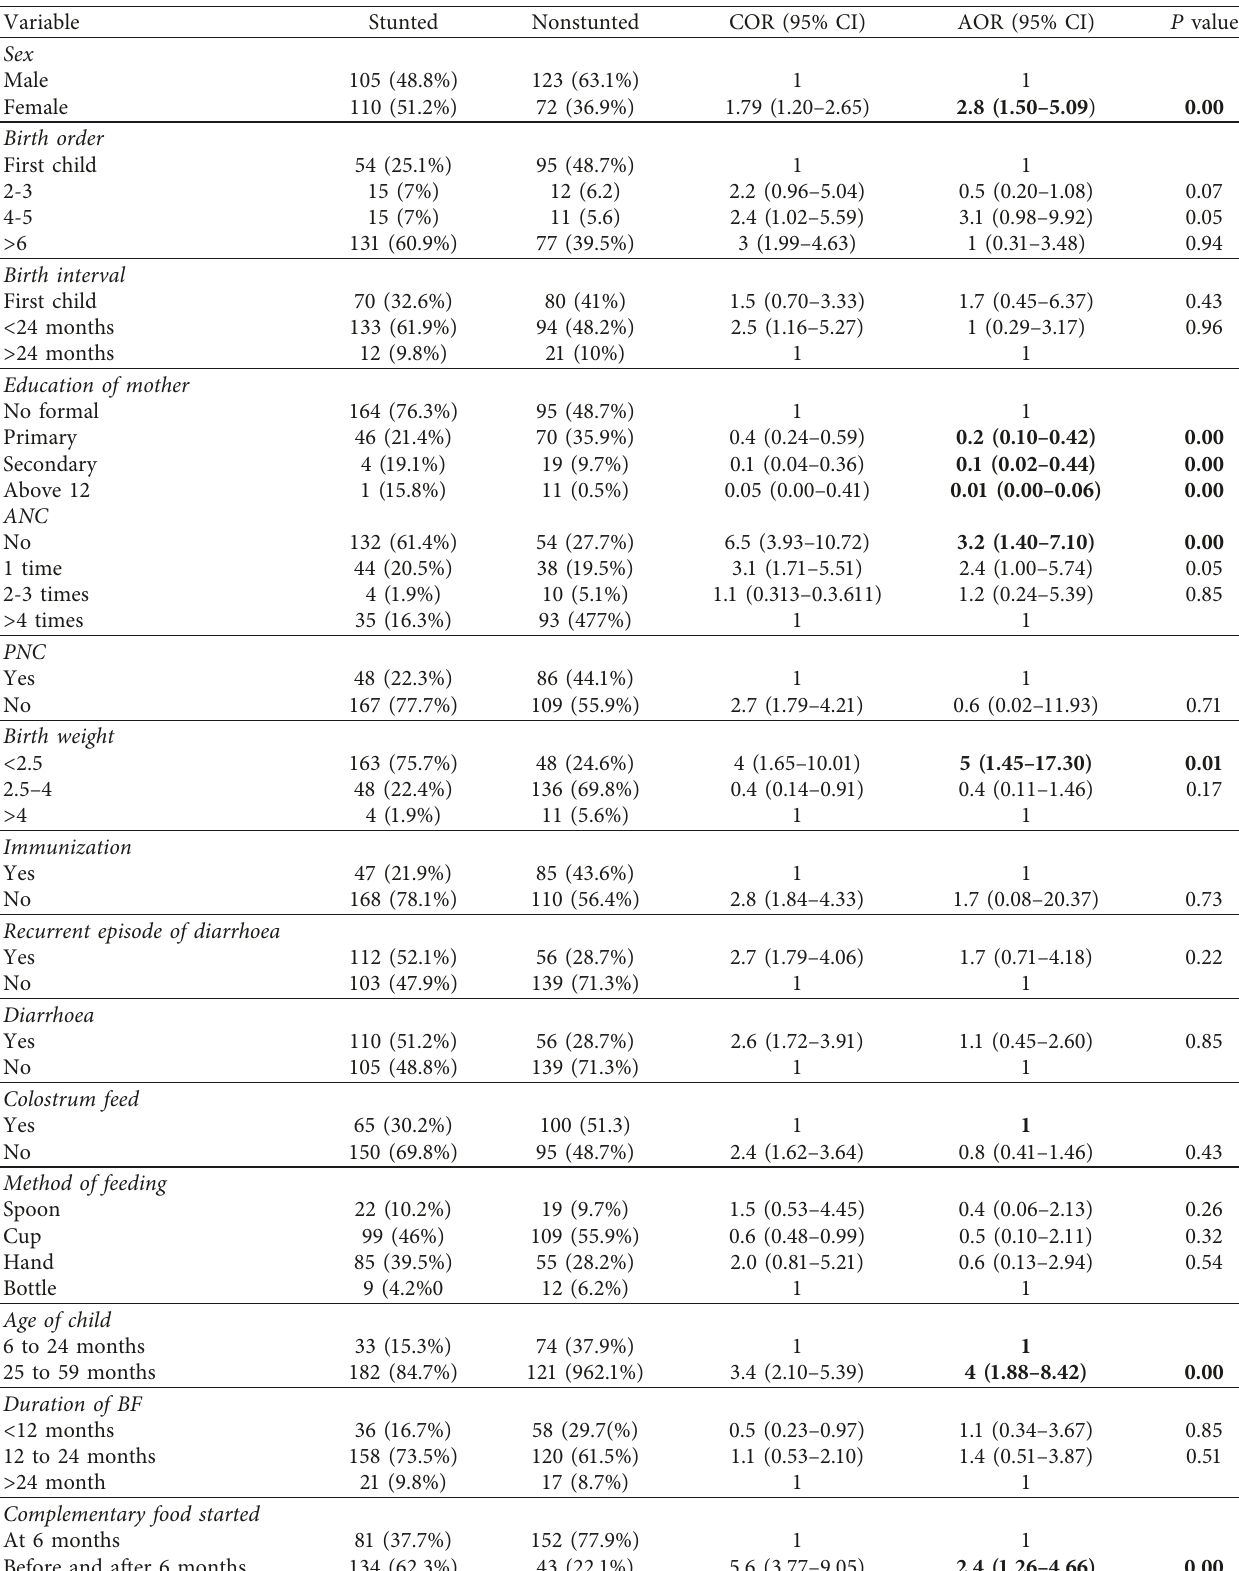
Table 4: Bivariate and multivariable logistic regression analysis of factors associated with stunting among children aged 6–59 months in Merhabete woreda, Ethiopia, 2017 ( n �